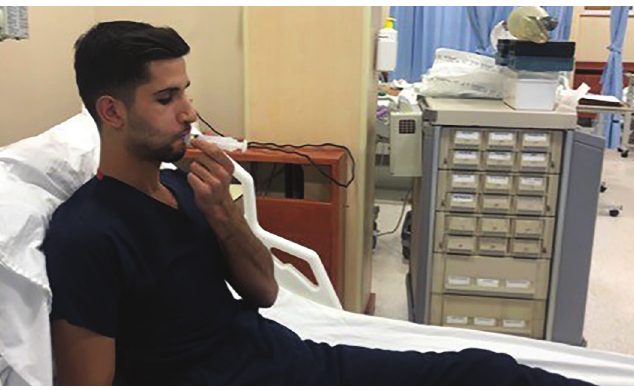
Figure 1. Valsalva maneuver is performed in the form of forced and sudden expiration with the glottis